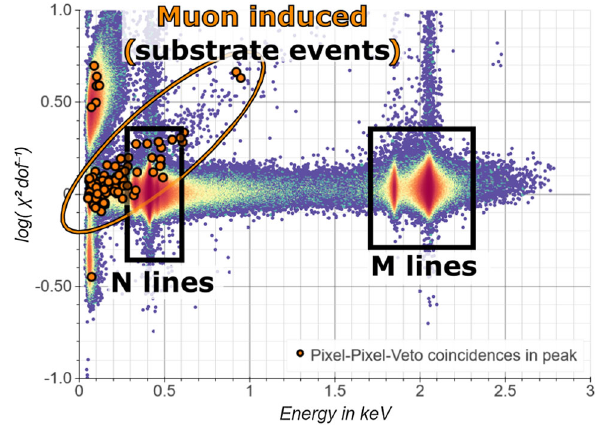
Fig. 10 The reduced χ 2 plotted against E Filter . The orange dots are the muon veto coincidences, which are in addition coincident to other pixel events. The 163 Ho EC lines are visible. The muon induced substrate events (true coincidences) have mostly low energies ( E < 500 eV) and